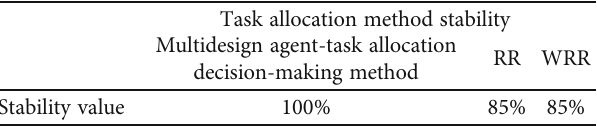
Table 22: Task allocation method stability. Task allocation method